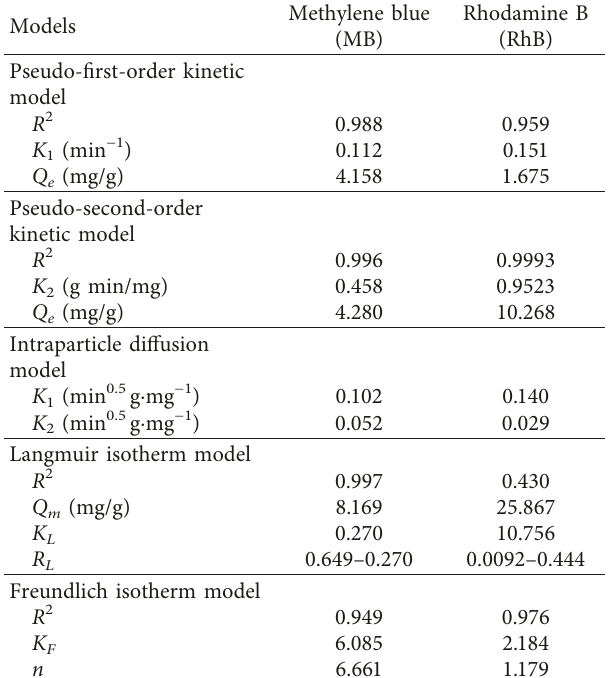
Table 2: Summary of data fitted onto various kinetic models.